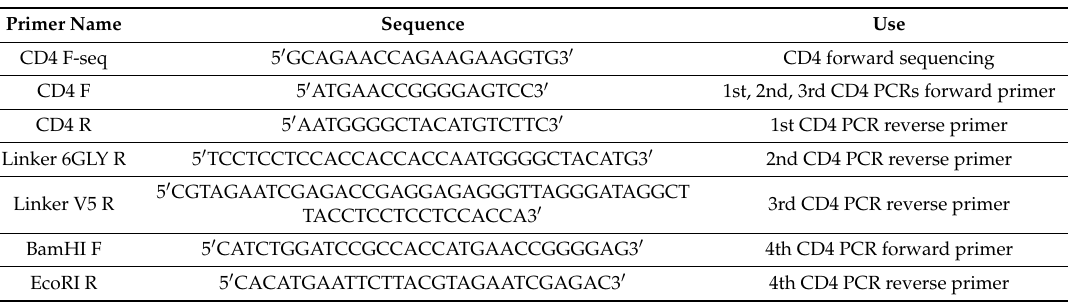
Table 1. Primers used in this study 1